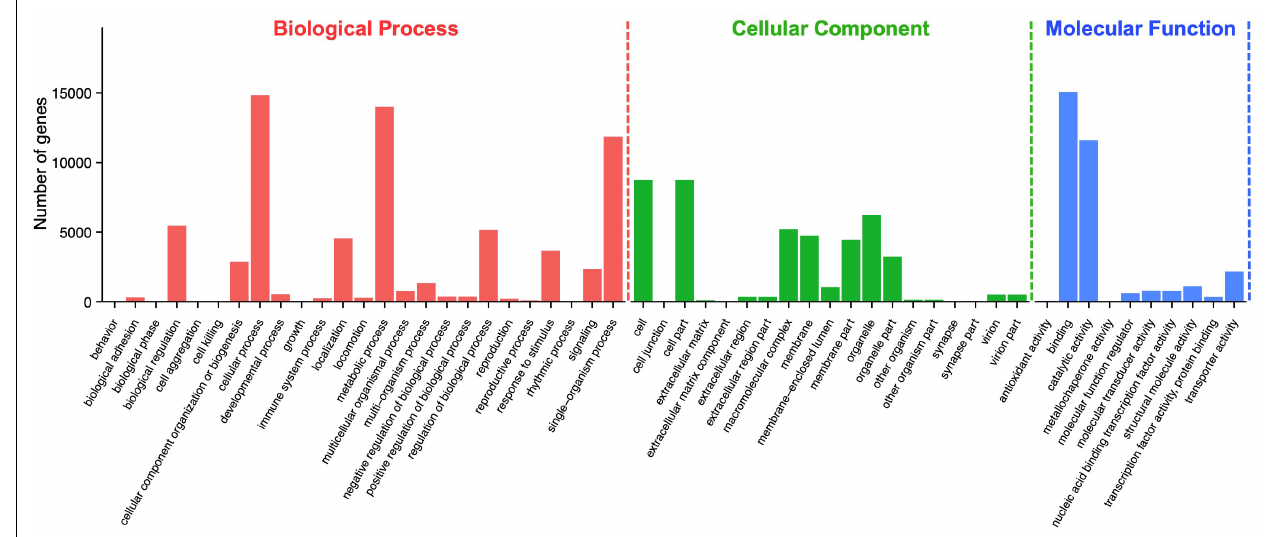
FIGURE 2 | Gene ontology (GO) assignment of Apriona germari unigenes. The GO classification map was done by uploading the GO ID numbers of genes for their involvement in biological processes, cellular components, and molecular